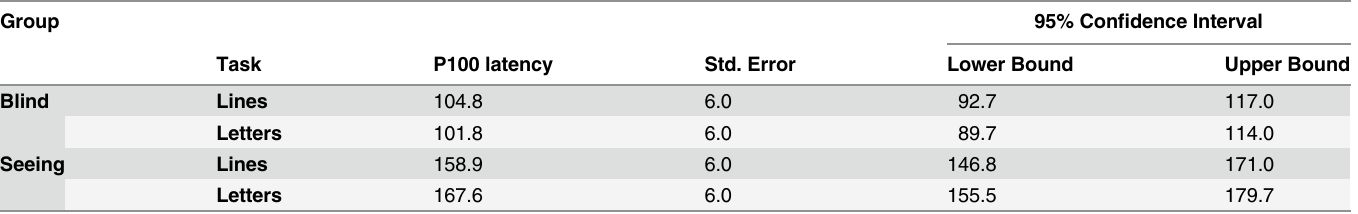
Table 3. Latency for P100 Evoked Potential Responses following presentation of lines or letters in non-target trials. Values represent mean and standard deviations of the P100 latency. Group 95% Con fi dence Interval Task P100 latency Std. Error Lower Bound Upper Bound Blind Lines